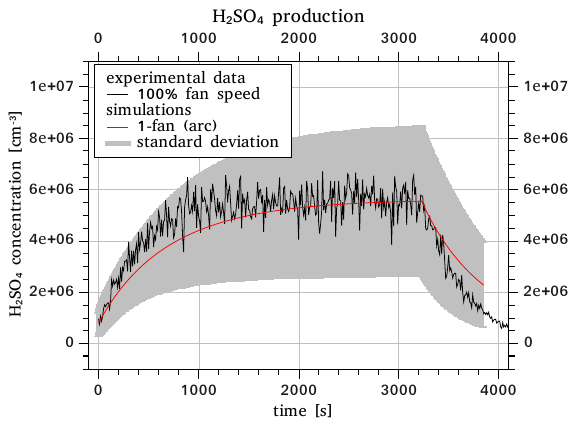
Fig. 7. Calculated H 2 SO 4 concentration with constant H 2 SO 4 pro- duction rate in comparison to experimental CLOUD-1 data (1-fan configuration). The source rate was 1.0 × 10 4 cm − 3 s − 1 .